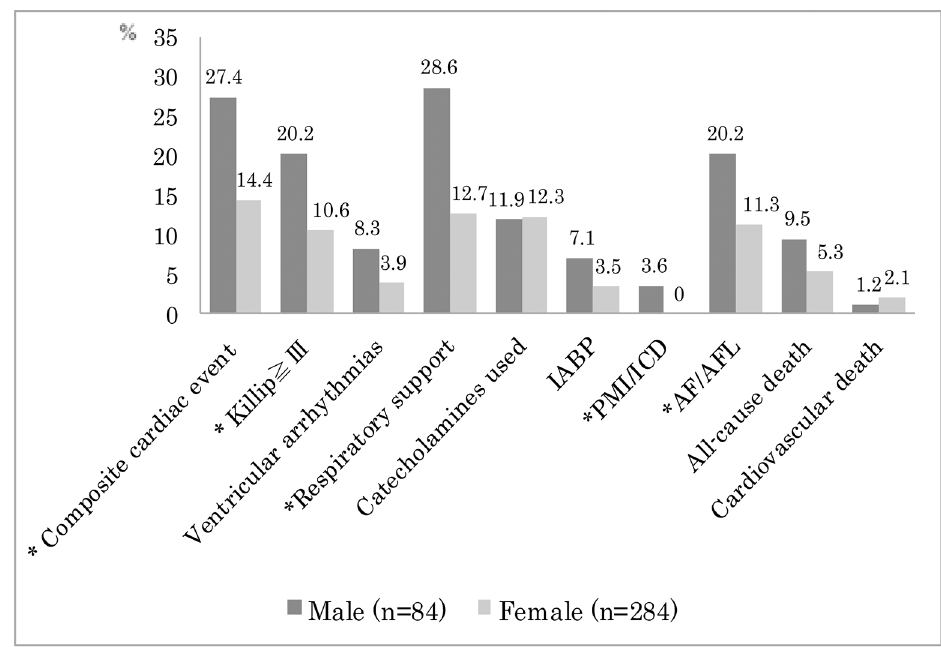
Fig 2. Cardiac complications and cardiopulmonary supportive therapies are shown by gender. Composite cardiac events are defined as cardiovascular death, severe pump failure, or serious ventricular arrhythmias (such as ventricular tachycardia/ventricular fibrillation (VT/VF)). Killip: Killip Class; ventricular arrhythmias: VT/VF; respiratory support: mechanical ventilation or non-invasive positive pressure ventilation; IABP: intra-aortic balloon pump; PMI/ICD: implantation of pacemaker or cardioverter-defibrillator; AF/AFL: atrial fibrillation or flutter. * P value: < 0.05.